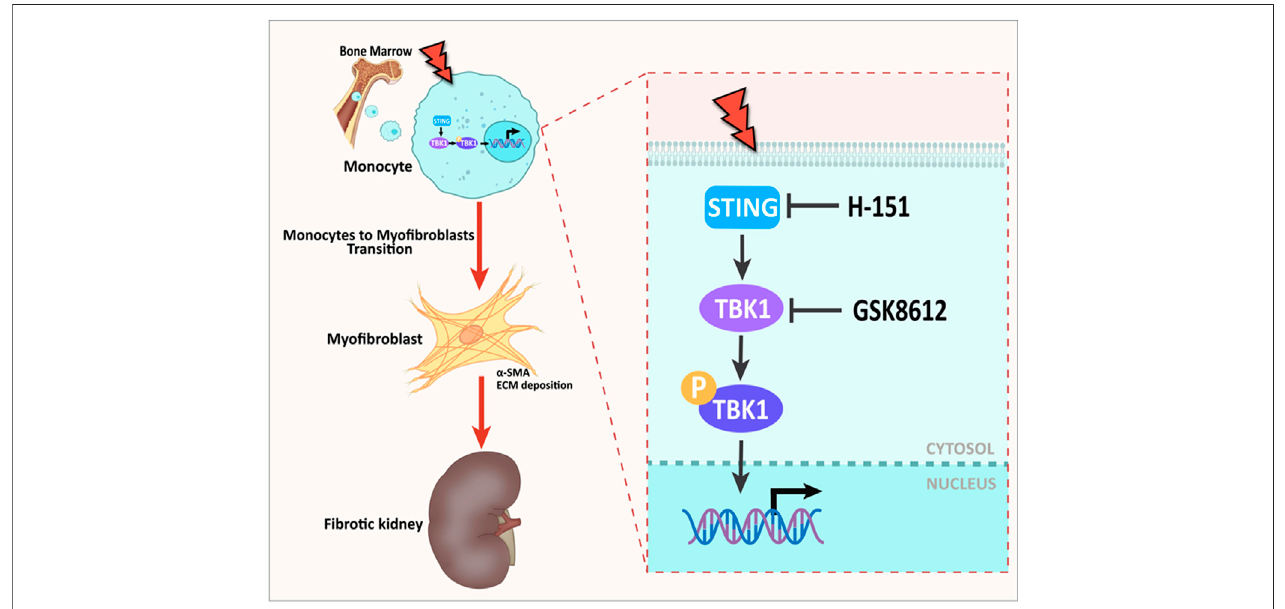
FIGURE 11 | Graphical abstract. The role of STING/TBK1 axis in progressive kidney fi brosis following folic acid stress. Folic acid stress triggers expressions of STING, which subsequently activates TBK1, leading to renal fi brogenesis. Pharmacological inhibition of STING/TBK1 signaling by H-151 or GSK8612 impairs myeloid fi broblasts activation, protects against macrophages to myo fi broblasts transition, thus delay the progression of kidney fi brosis.